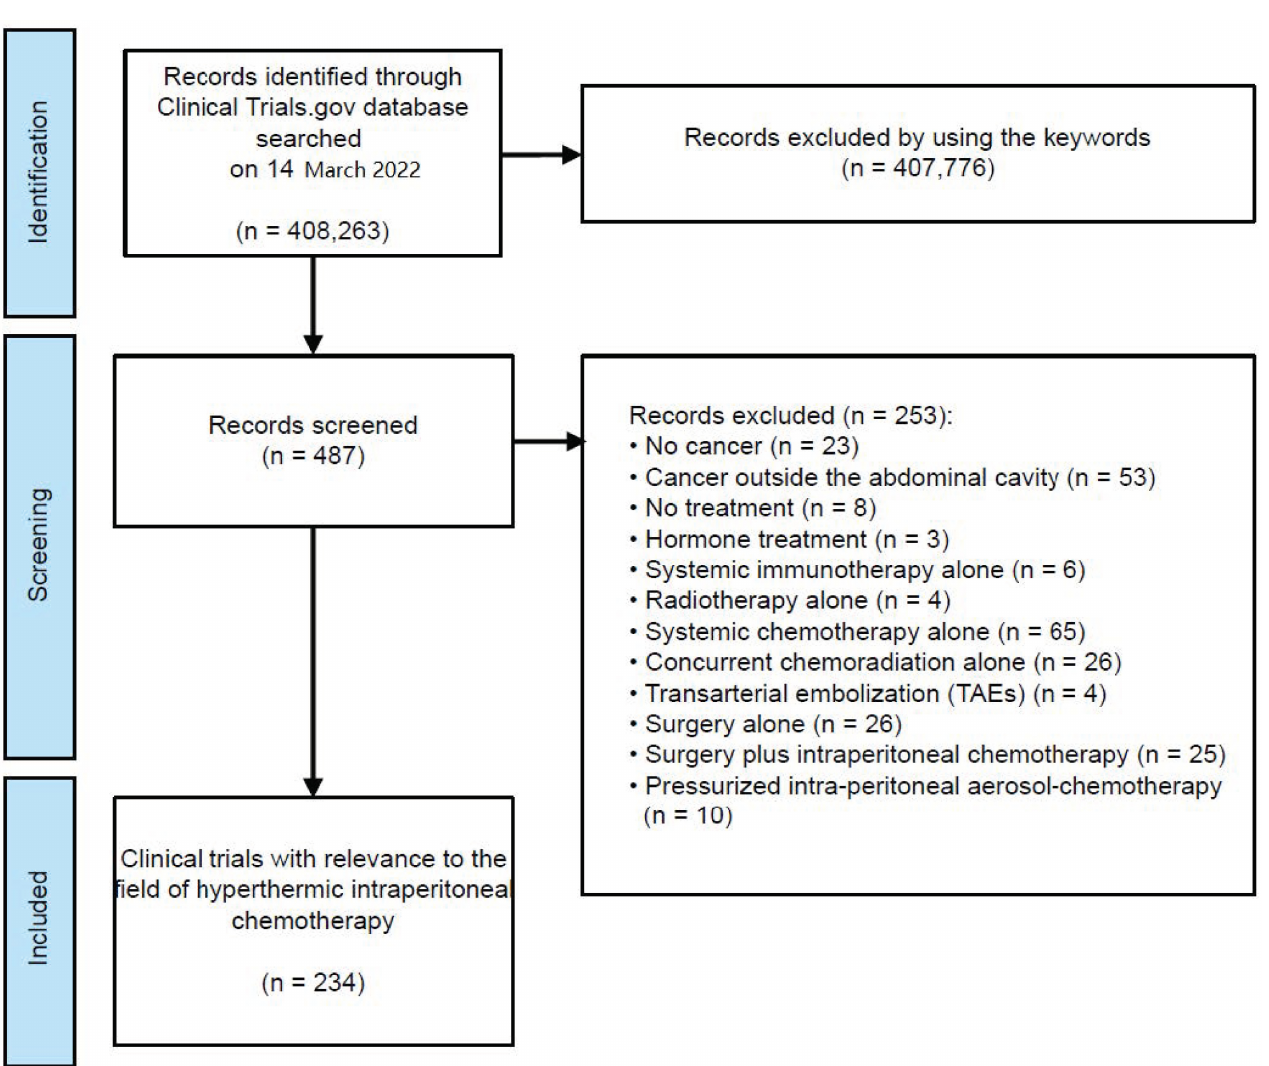
Figure 1. Flow diagram of search for trials from ClinicalTrials.gov, adapted from the Preferred Reporting Items for Systematic Reviews and Meta-Analyses (PRISMA) statement.